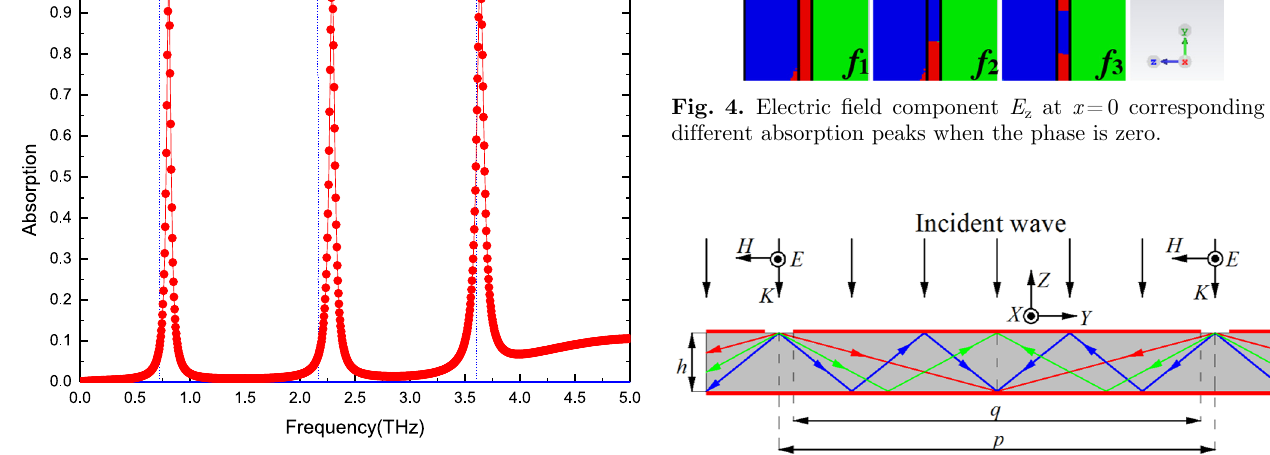
Fig. 2. Simulated absorption spectra induced by incident EM waves.